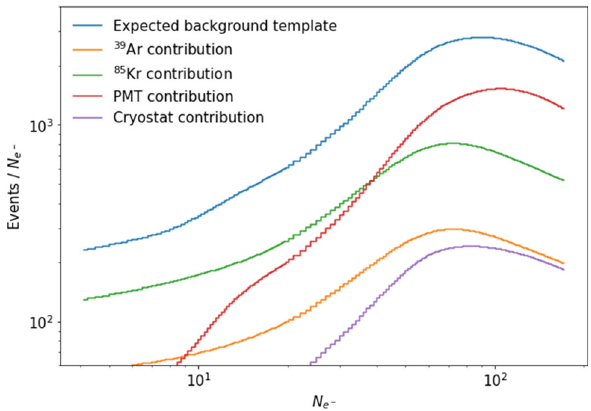
Fig. 5 Theso-calledAsimovdataset,namelytheexpectedbackground (blue line) in the N e − = [4 , 170] range, assuming the DS-50 exposure. The different colored lines represent the expected contributions from the different background sources. The spectra have a 0 . 25 N e − binning for N e − < 20 and a 1 N e − elsewhere, see